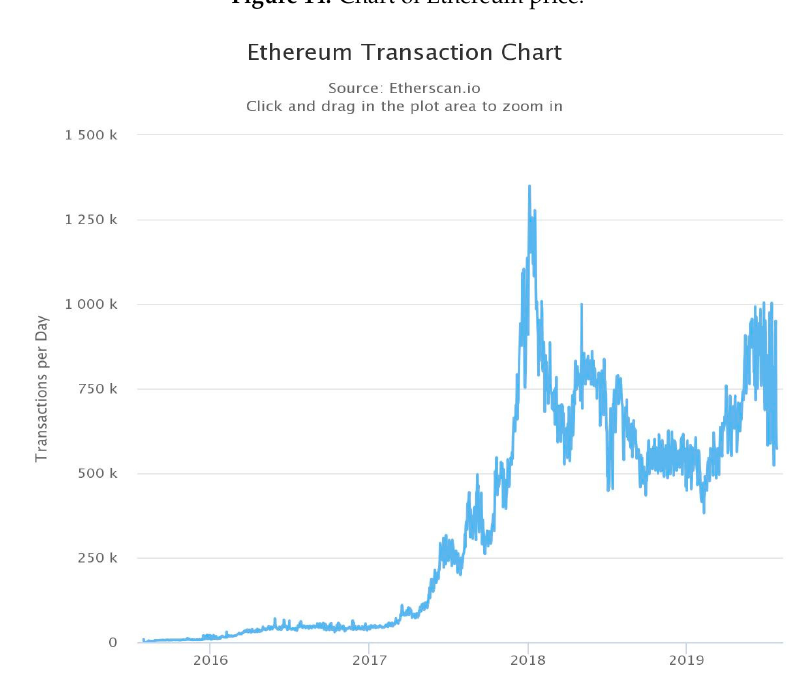
Figure 15. Transactions chart.